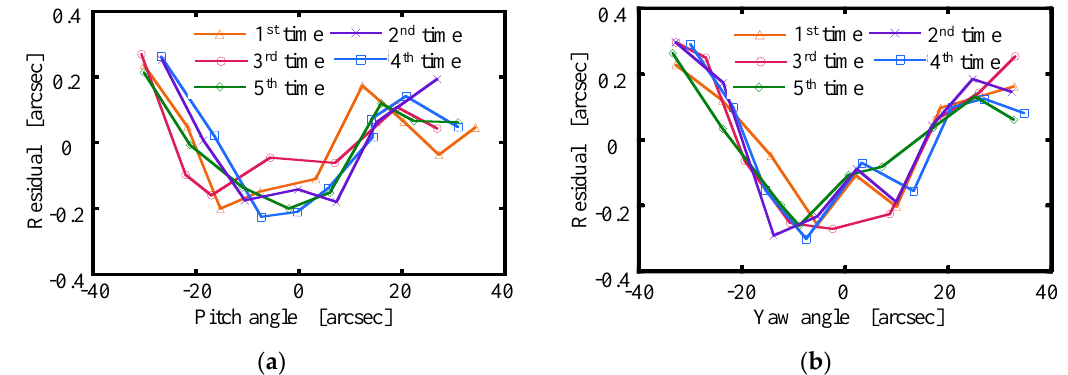
Figure 7. Calibration angle results of the miniature autocollimator kit: ( a ) pitch; ( b ) yaw.